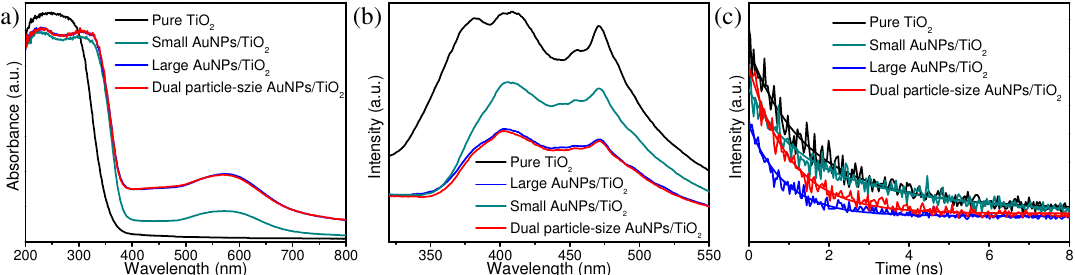
Figure 4. ( a ) UV-vis diffuse-reflectance spectra, ( b ) photoluminescence spectra, and ( c ) time-resolved luminescence decay spectra of pure TiO 2 , small AuNPs/TiO 2 , large AuNPs/TiO 2 , and dual particle-size AuNPs/TiO 2 hybrids.